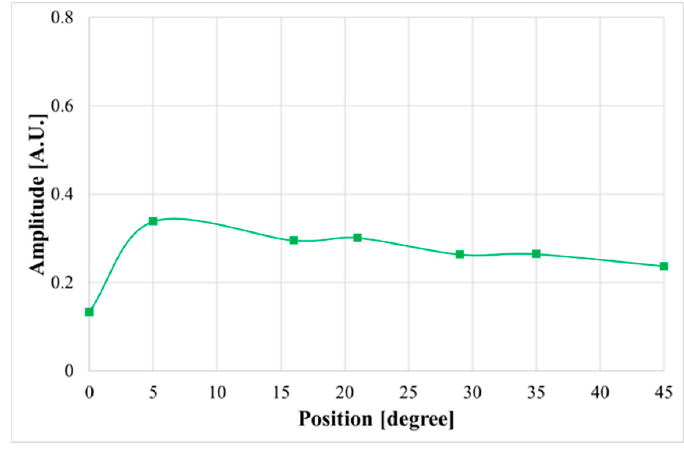
Figure 10. The amplitude variation with coil position of the simulation analysis results.